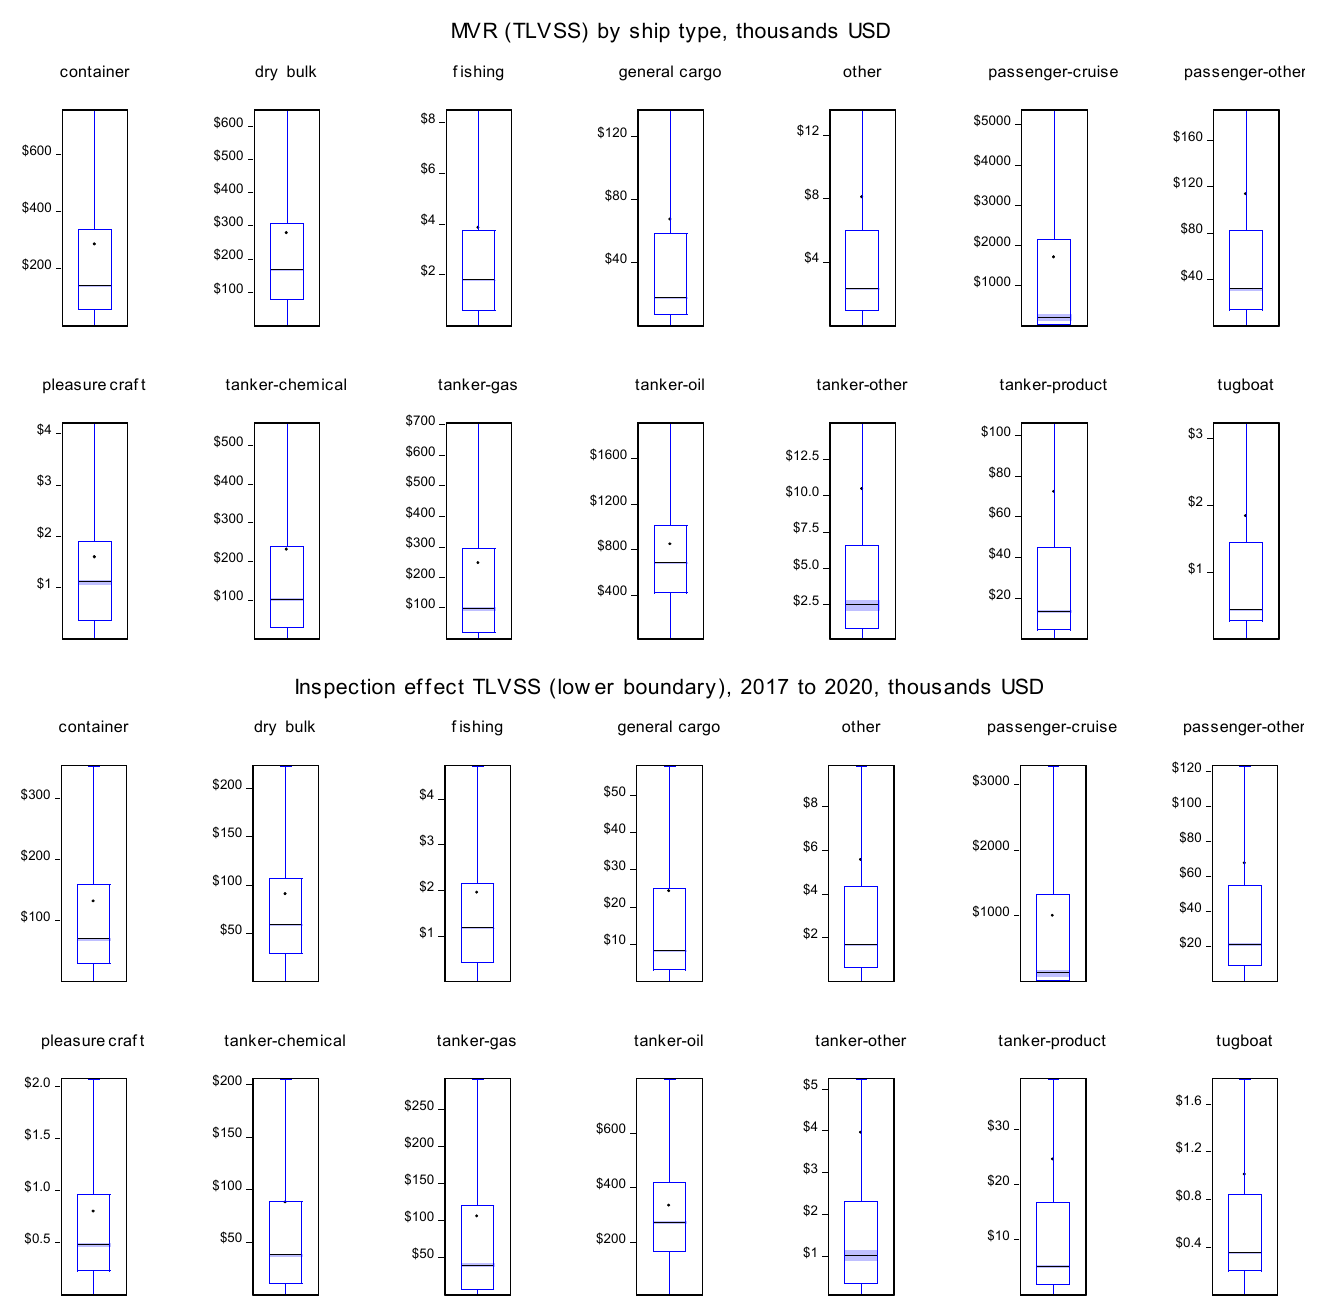
Figure A1. Boxplots of MVR components (incident probabilities, damage type probabilities, and EEZ factors).